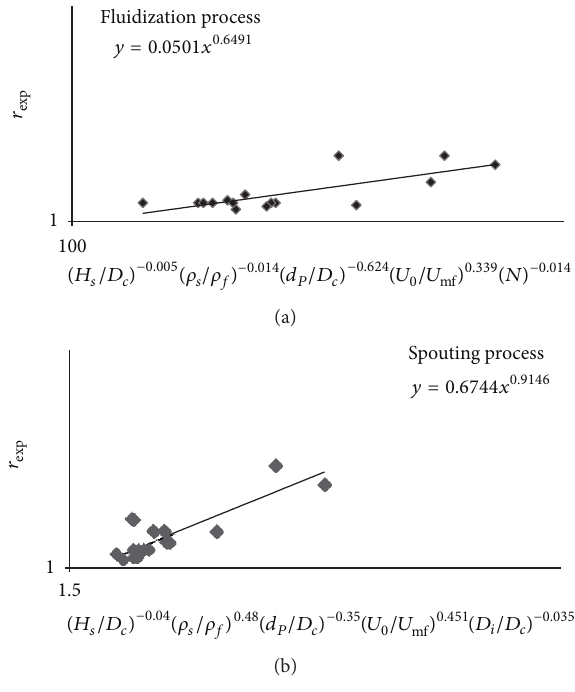
Figure 8: Correlation plot of bed fluctuation ratio against system parameters for fine particles.